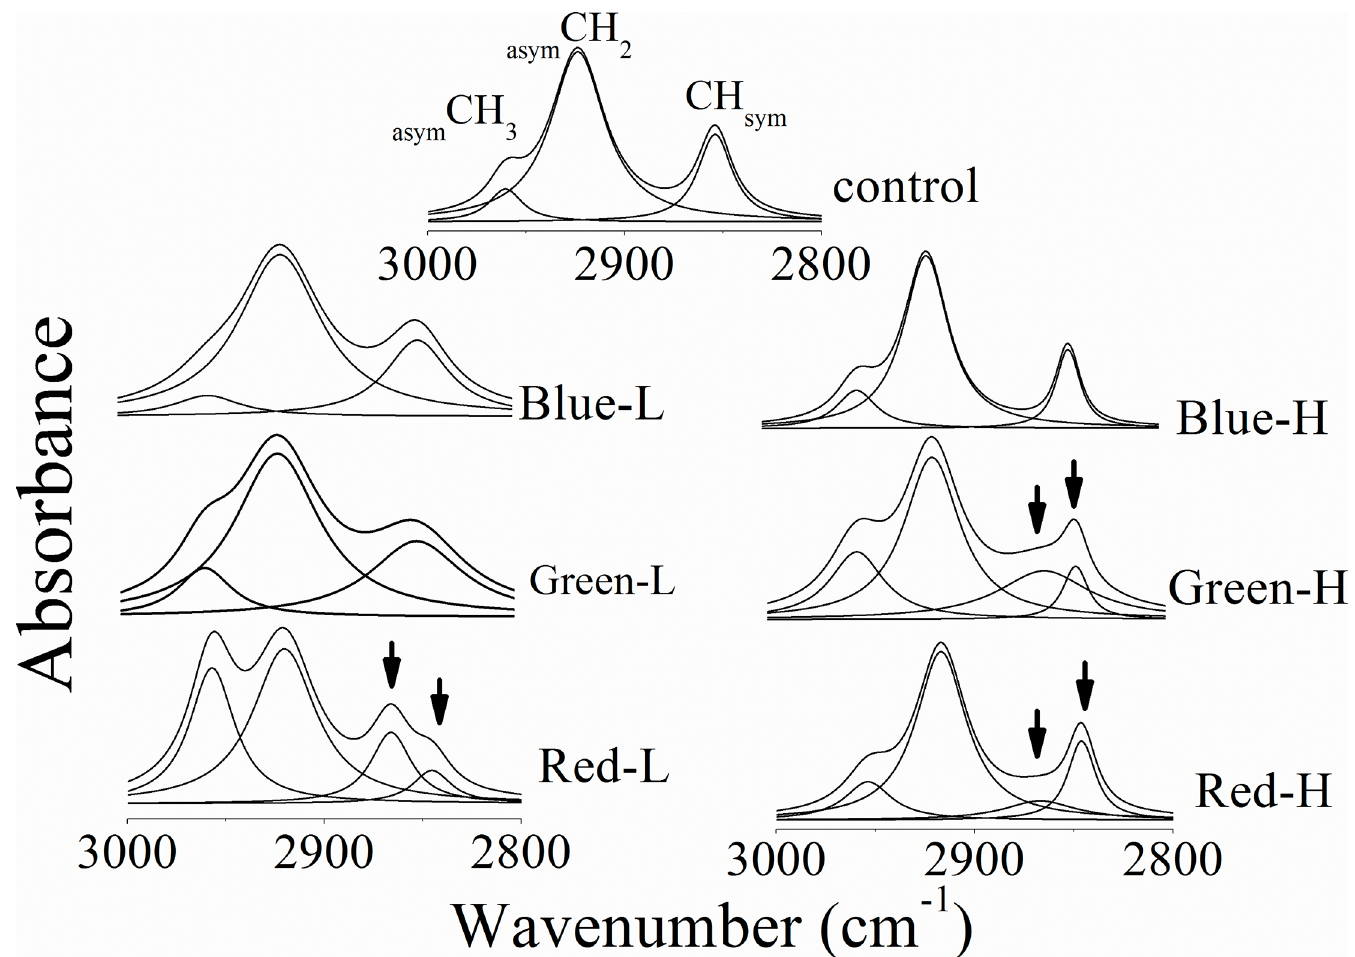
Fig 2. Corneas CH stretching region. Arrows are pointing to the splitting of CH sym mode into sym CH 3 and sym CH 2 .